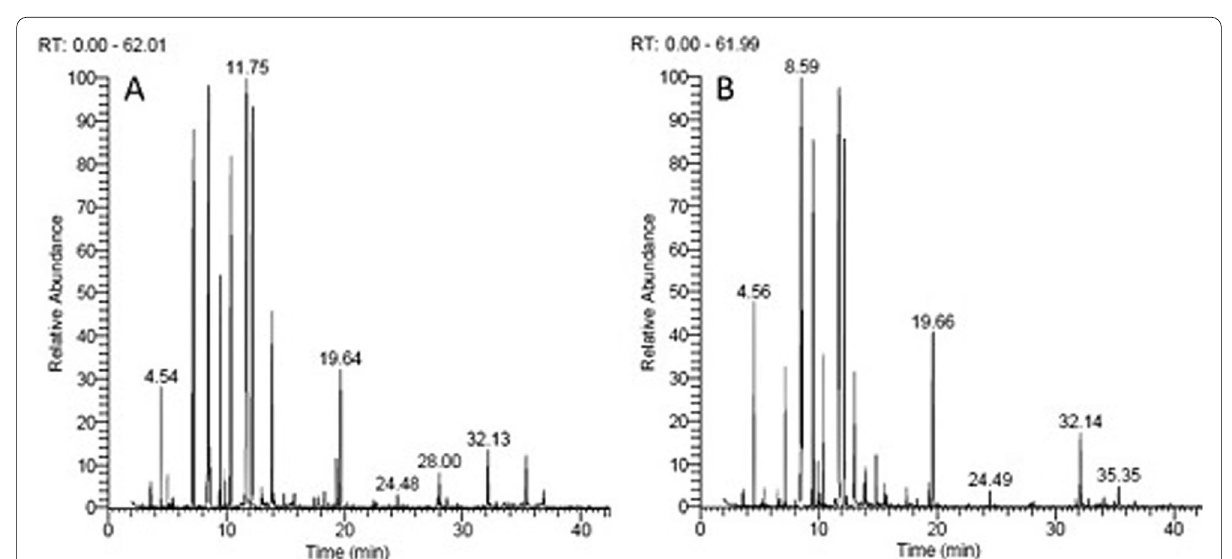
Fig. 5 GC‑MS total chromatogram for the volatile oil of the two fragrantissima wild accessions W1‑3 and W